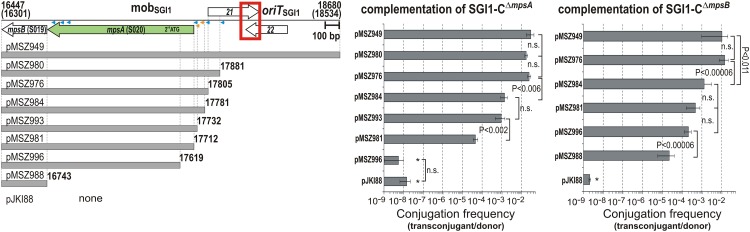
Identification of promoter regions driving expression of mpsA and mpsB. The fragments cloned into the complementing plasmids are shown below the schematic map of mobSGI1 region. Putative promoter elements predicted by BPROM or found by manual search are indicated by blue or yellow arrowheads, respectively. Other symbols are as in Figure 1B. Transfer frequency of SGI1-CΔS020 and SGI1-CΔS019 was measured in the presence of one of the complementing plasmids and the helper plasmid R55ΔTn6187. Plasmid pMSZ984 showed high st. deviations in three independent complementation assays carried out with 3–6 replicates with SGI1-CΔS019, thus the complementation efficiency of this plasmid could not exactly be determined. However, mean values appeared similar to that of pMSZ981 and pMSZ996. ∗Transconjugants resulting from oriTSGI1-independent transfer pathway.